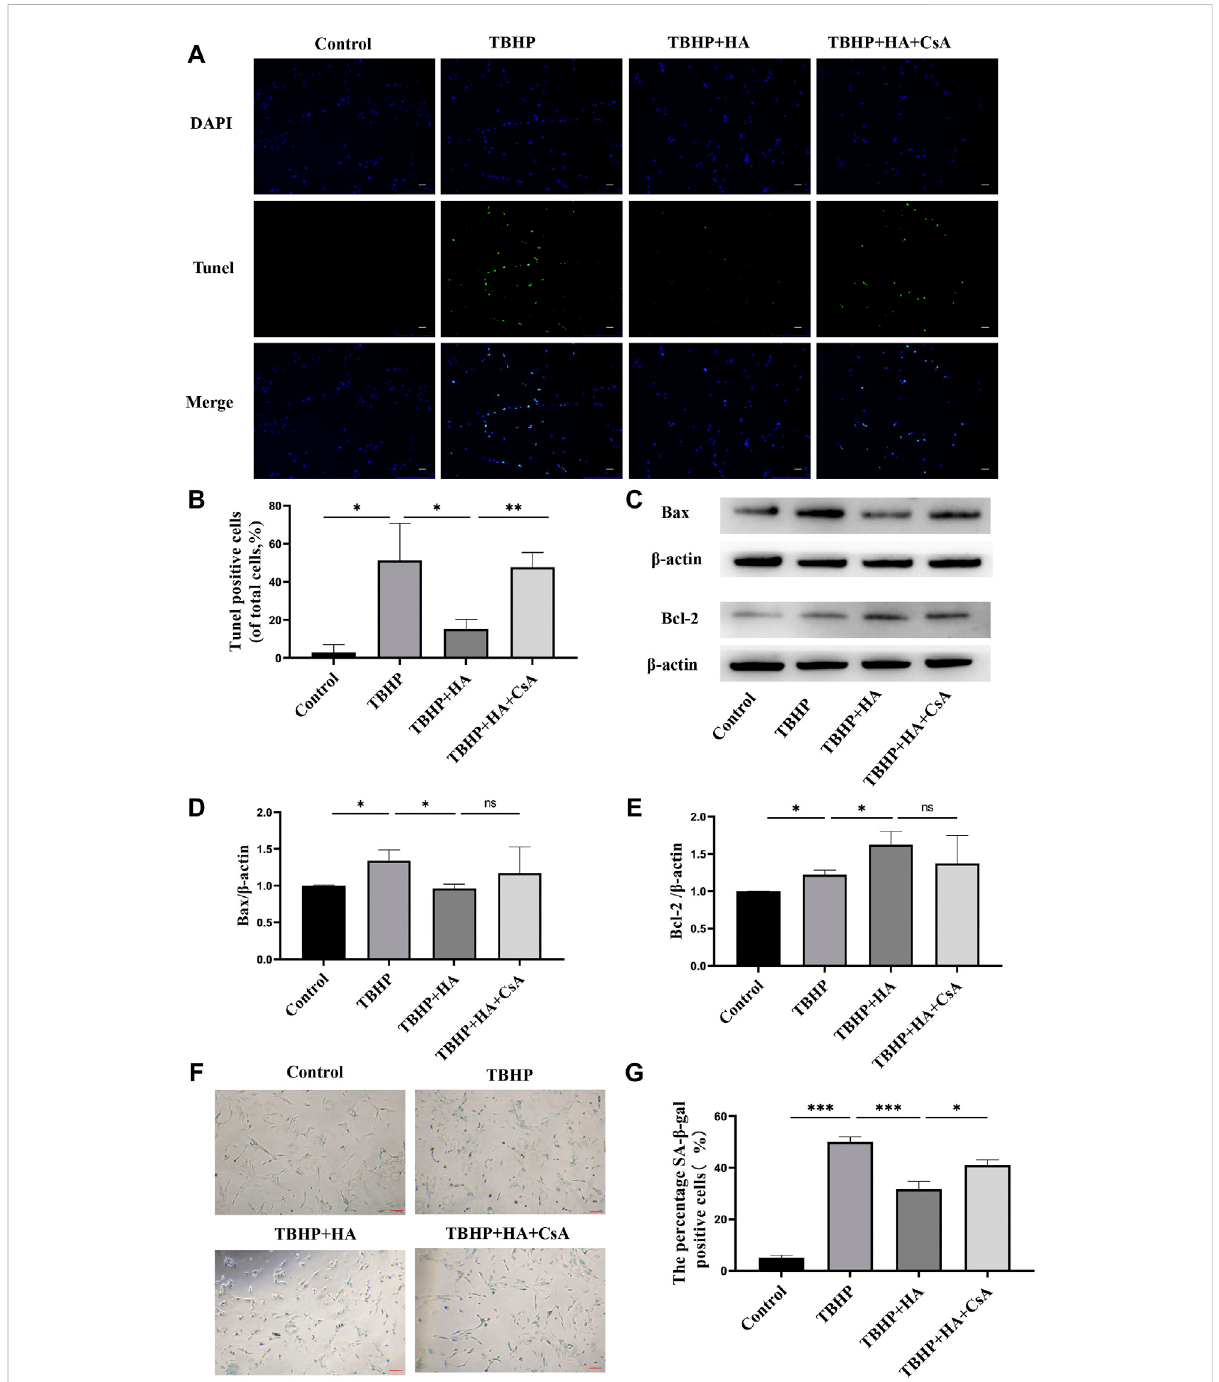
FIGURE 3 HA attenuates TBHP-induced apoptosis and senescence in NPCs. (A,B) TUNEL assay was performed in NPCs as treated above. Scale bar: 50 μ m. (C – E) Western blotting was performed to detect the expression of apoptosis-related proteins Bax and Bcl-2 in NPCs. (F,G) Representative imagesofSA- β -galstainingofNPCs.Scalebar:100 μ M.Dataarerepresentedasthemean±SD.ns,notsigni fi cant,* p < 0.05,** p < 0.01,*** p < 0.001. n =